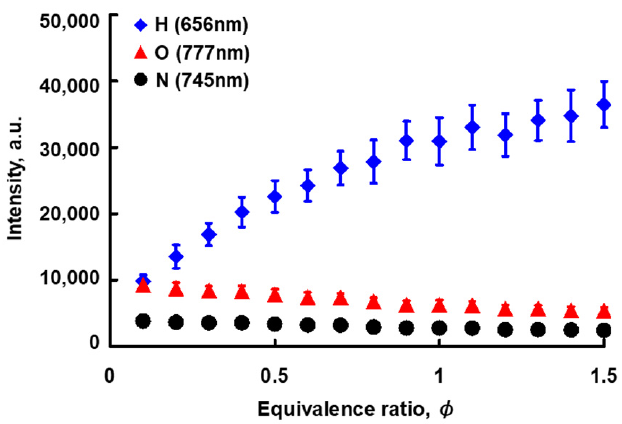
Figure 5. Relationship between atomic spectrum intensity and equivalence ratio (propane–air mixture). Only the H atomic spectra has higher sensitivity with the change of equivalence ratio.